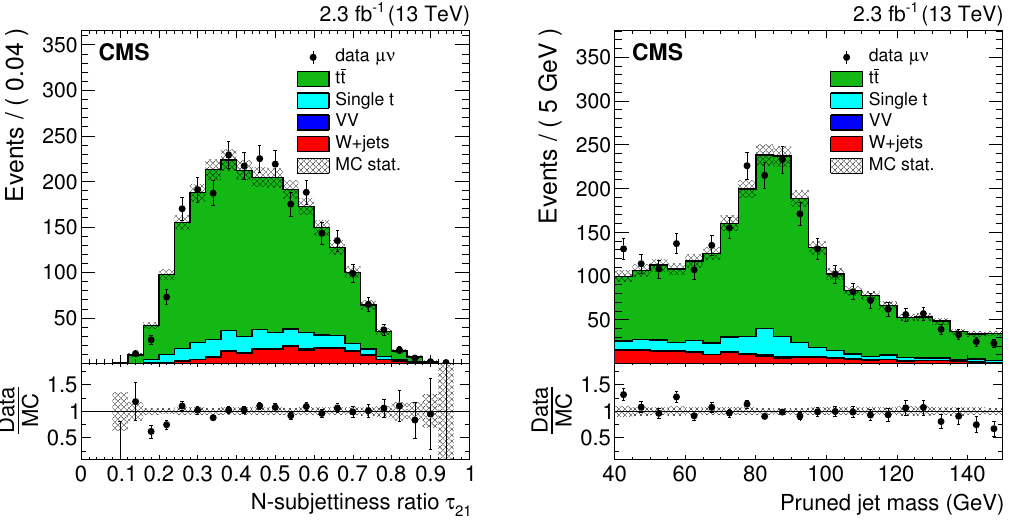
Figure 2 . Distributions in N -subjettiness ratio (cid:28) 21 (left) and pruned m jet (right) from the top quark enriched control sample in the muon channel. The tt background is rescaled such that the total number of background events matches the number of events in data. In the lower panel of each plot, the ratio between data and simulation is shown together with the statistical uncertainty in the simulation normalized by its central